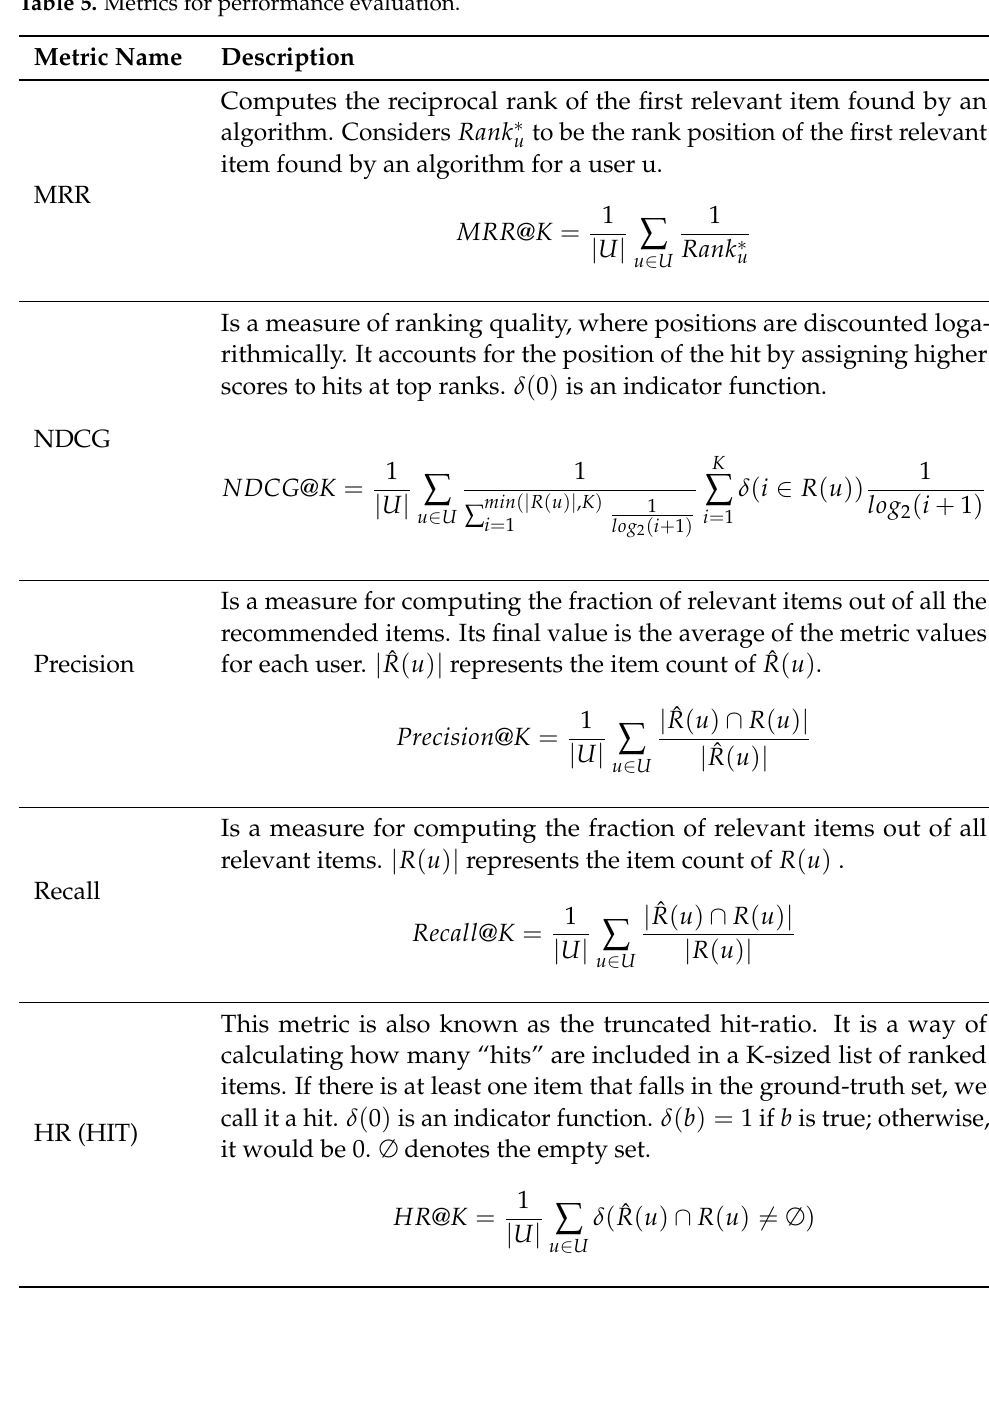
Table 5. Metrics for performance